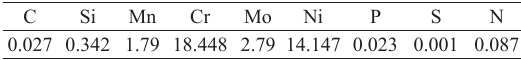
Table 1. Chemical composition of ASTM F138 steel (mass -%).